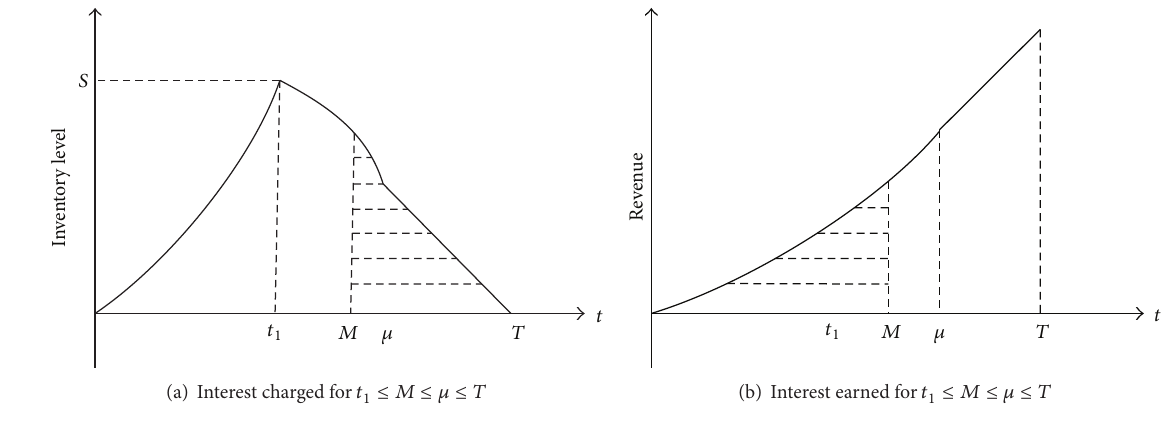
Figure 3: Interest charged and interest earned for 𝑡 1 ≤ 𝑀 ≤ 𝜇 ≤ 𝑇 .